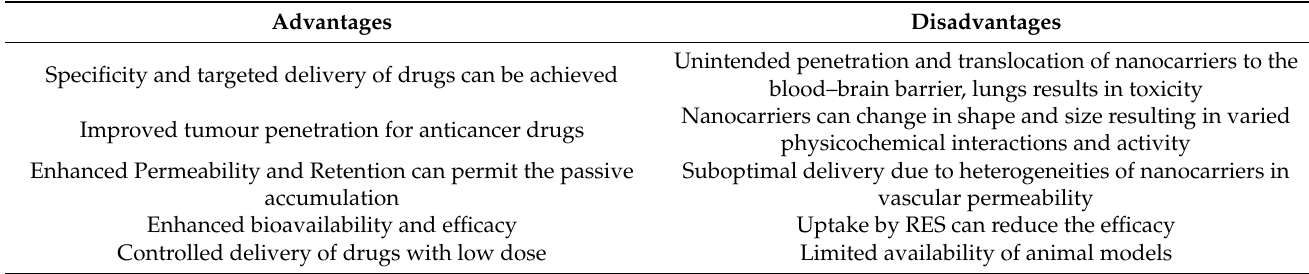
Figure 32. Some common examples of nanocarriers in controlled drug delivery. Table 9. Advantages and disadvantages of nanocarriers in drug delivery